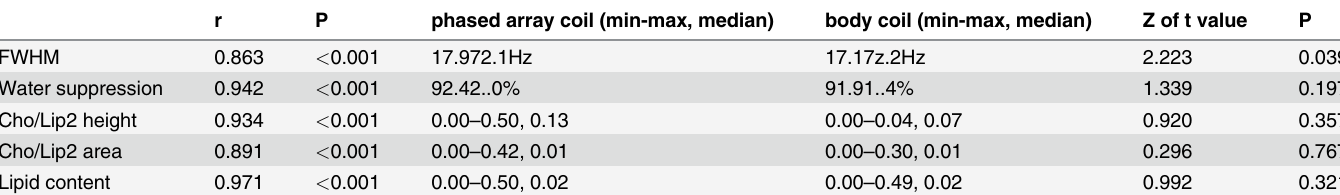
Table 1. Comparison of hepatic MRS prescan and metabolites content using phased array coil and body Coil ( n = 20).